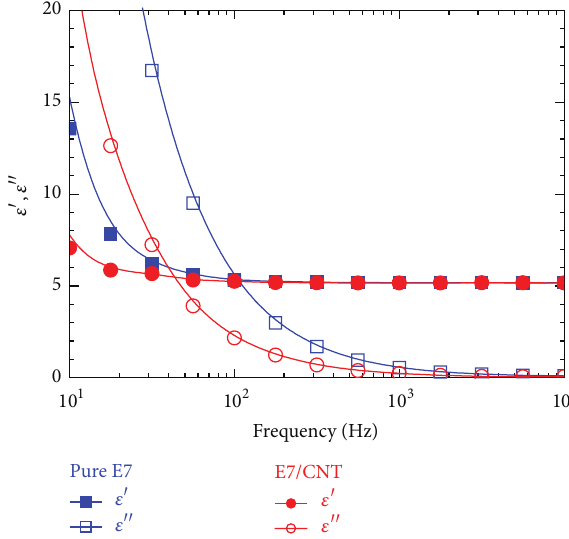
Figure 2: The dielectric spectra of pristine and 0.05 wt% CNT- doped CYLC-01 in homogeneously aligned cells at 303 K.